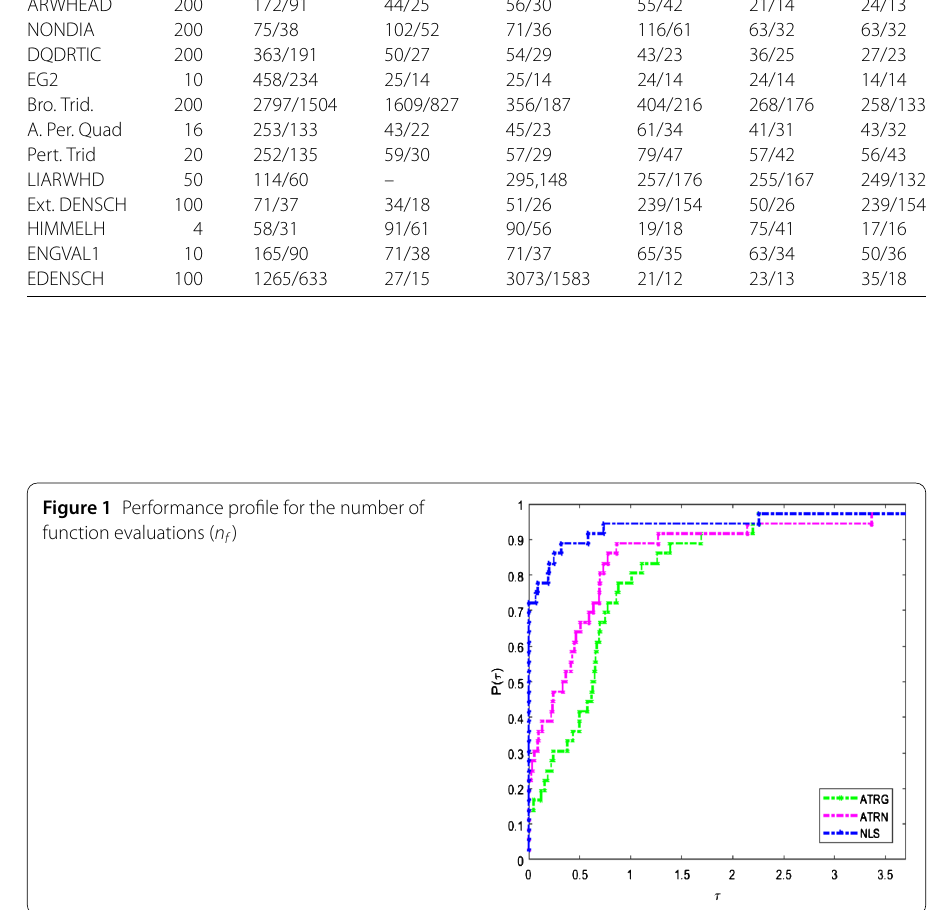
Table 1 Comparison between adaptive trust region methods and a new method. Problem n n f / n i Ext. Rose